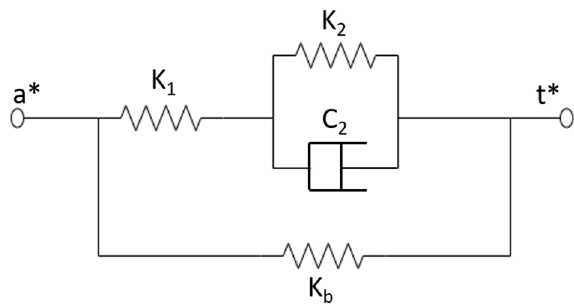
Figure 3. Four ‐ parameter Viscoelastic Model. Table 1. Related parameters of four ‐ parameter viscoelastic model.